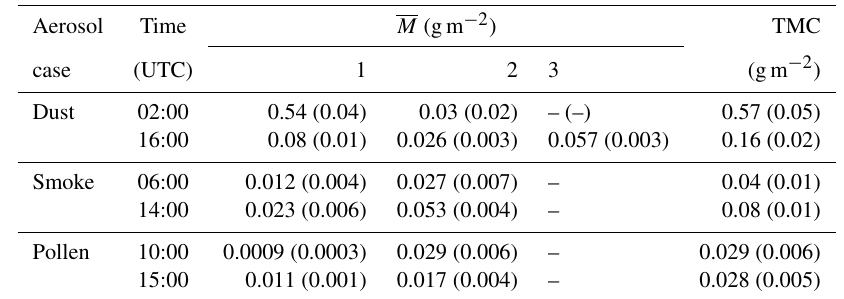
Table 4. Height-integrated mass concentration ( M i , i.e. mass loading, gm − 2 ) for each component and the total mass concentration (TMC) indicated for two times for each aerosol case. Errors are shown in parentheses.